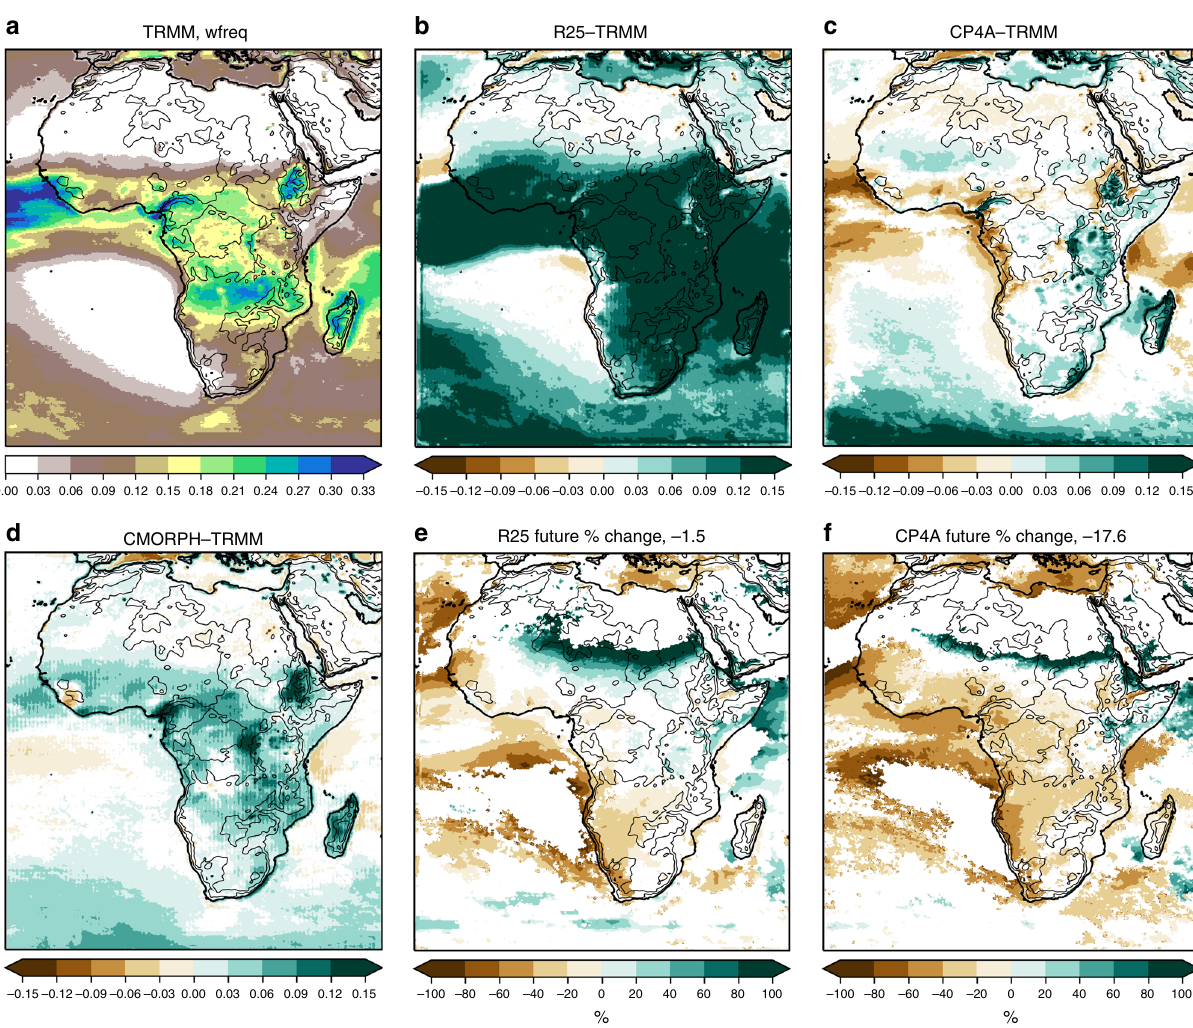
Fig. 3 Wet season 3-hourly precipitation occurrence. a TRMM observations, differences with respect to TRMM for b the R25 model, c CP4A model and d CMORPH observations, and percentage differences between 2100 and present day for e the R25 model and f CP4A model. Precipitation occurrence is de fi ned as the frequency of wet values (>0.1 mm h − 1 ). The median of future percentage changes across Africa (land points only) is indicated in e , f . Dataset differences and future changes are masked in white, where differences are not signi fi cant at the 5% level compared with year-to-year variability. The wet season is the 3-month period with the highest mean precipitation in TRMM, de fi ned on a grid-point basis. The black lines indicate the 500 -, 1000-, 2000-, 3000 - and 4000 -m height